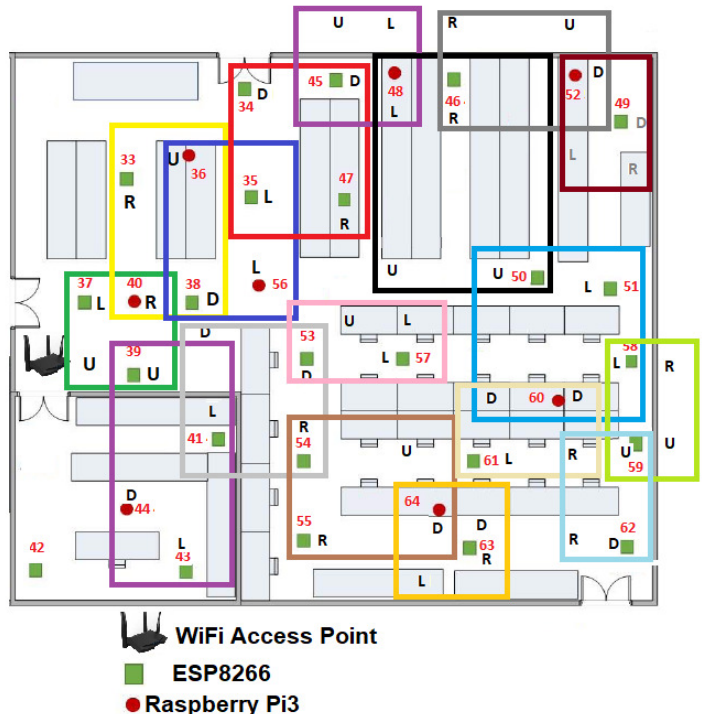
Figure 16. Hilbert fractal used for sorting the half of the reliable members of the proposed WSN applied in a experimental floor plan.